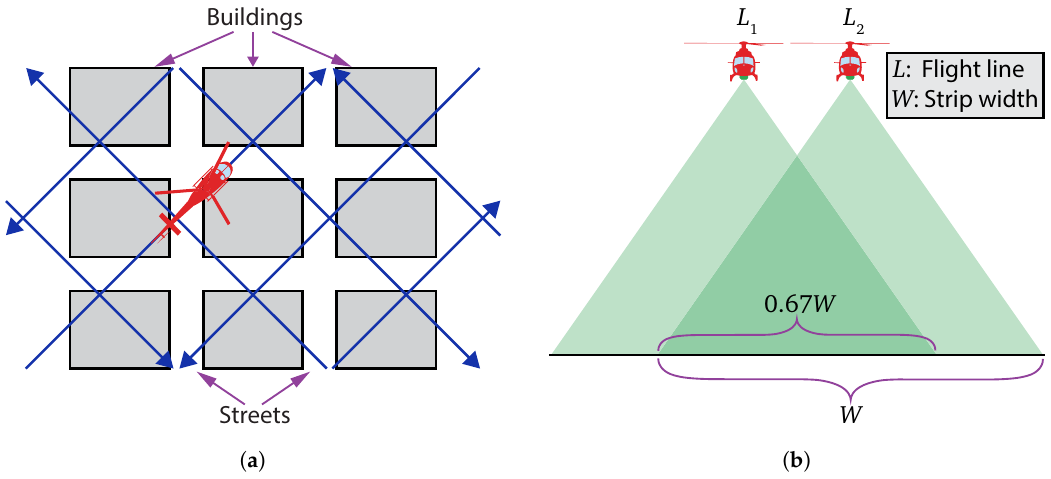
Figure 13. As proposed by Hinks et al. [42], airborne LiDAR data suitable for urban modeling tasks can be acquired using: ( a ) two sets of parallel flight lines perpendicular to each other, which are oriented 45 ◦ from the street layout, and ( b ) a 67% overlap between adjacent strips.